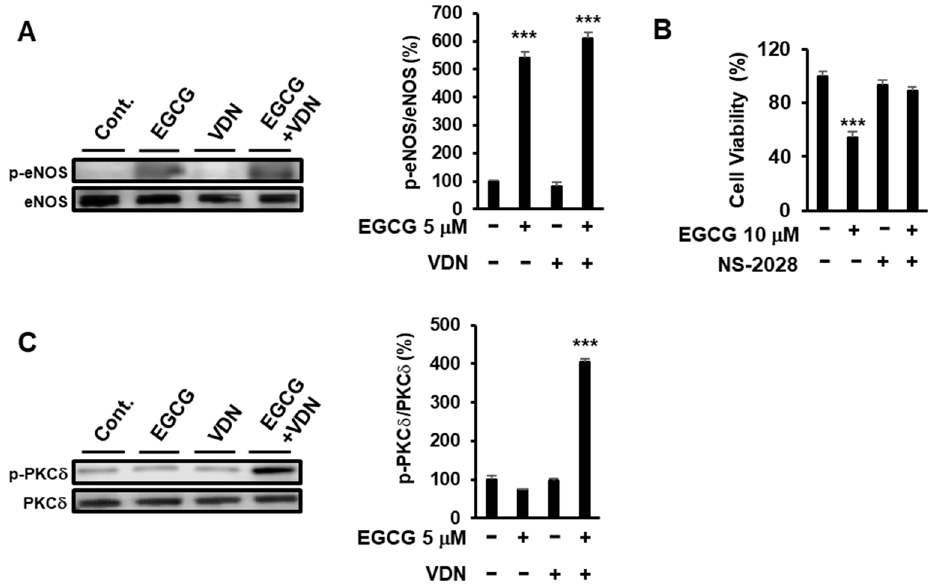
Figure 6. Inhibition of PDE5 potentiates EGCG-induced apoptotic cell death via the eNOS/cGMP/PKC δ signaling pathway. ( A ) Caco-2 cells were treated with 5 μ M EGCG and 5 μ M VDN for 1 h. Phosphorylation of eNOS at Ser1177 was measured using Western blotting. ( B ) Cells were treated with 10 μ M EGCG and 5 μ M of soluble guanylyl cyclase inhibitor (NS-2028). After 96 h, cell viability was determined. ( C ) Cells were treated with 5 μ M EGCG and 5 μ M VDN for 3 h. Phosphorylation of PKC δ at Ser664 was measured using Western blotting. Data are presented as mean ± SEM ( n = 3); *** p <